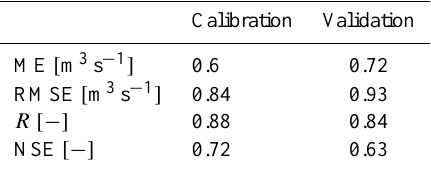
Table 6. Statistical performance of total hourly river flows for the model calibration and validation periods at the outlet station of the Grote Nete catchment.